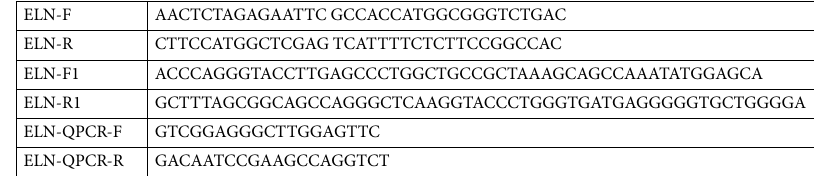
Table 1. The primers used in construction of the plasmid, point mutation, and